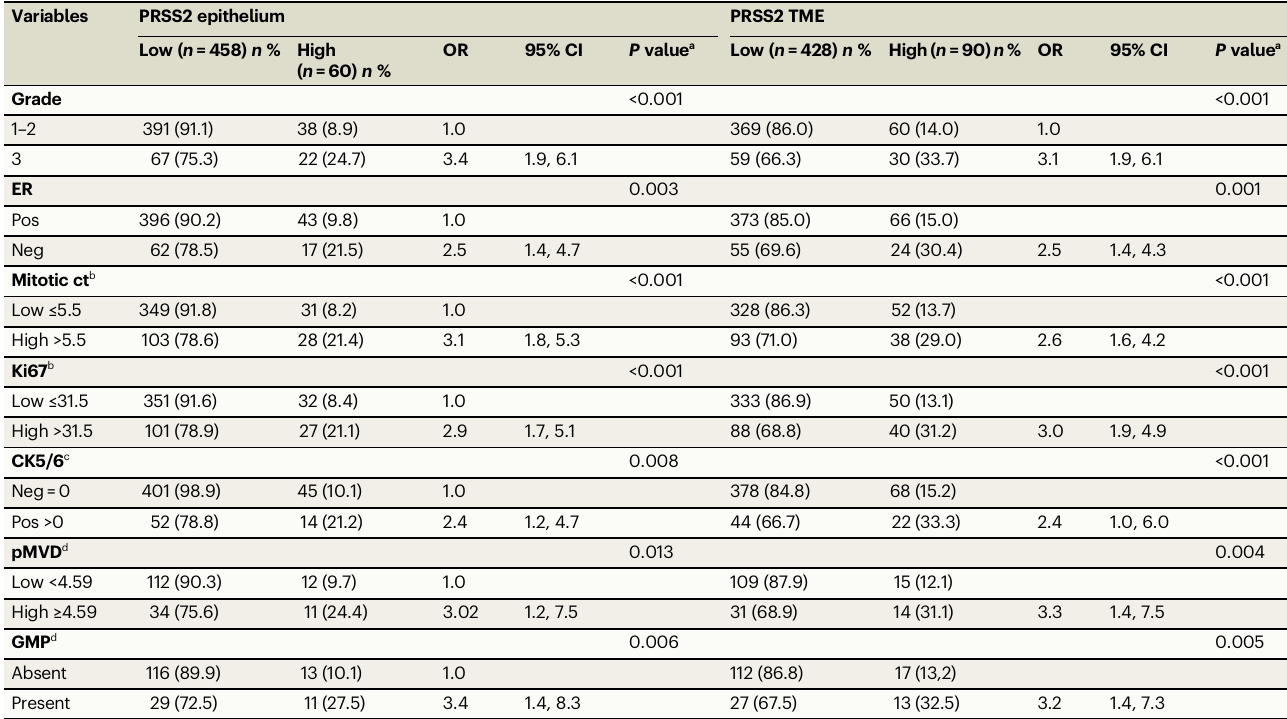
Table 1 | Breast cancer (Series